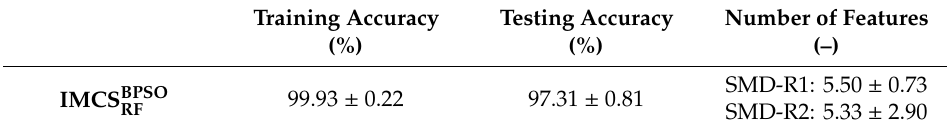
Table 4. Classification performance of the random forest (RF) technique over 20 independent runs.